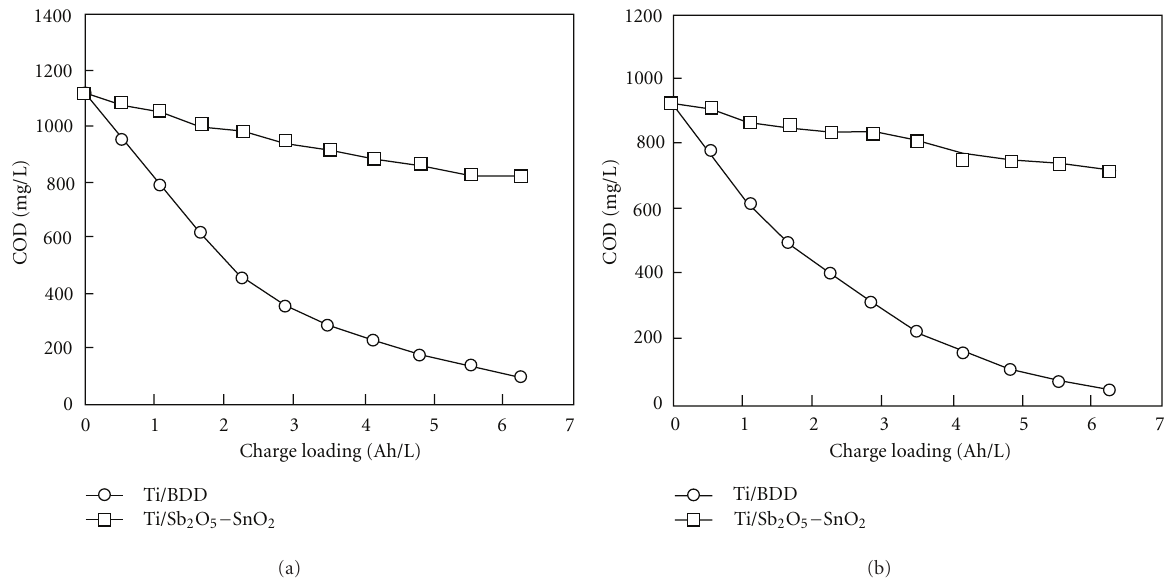
Figure 2: COD decay for comparison of Ti/BDD versus Ti/Sb 2 O 5 − SnO 2 for incineration (a) Orange II and (b) Reactive red HE-3B at current density 200 A/cm 2 and T = 30 ◦ C